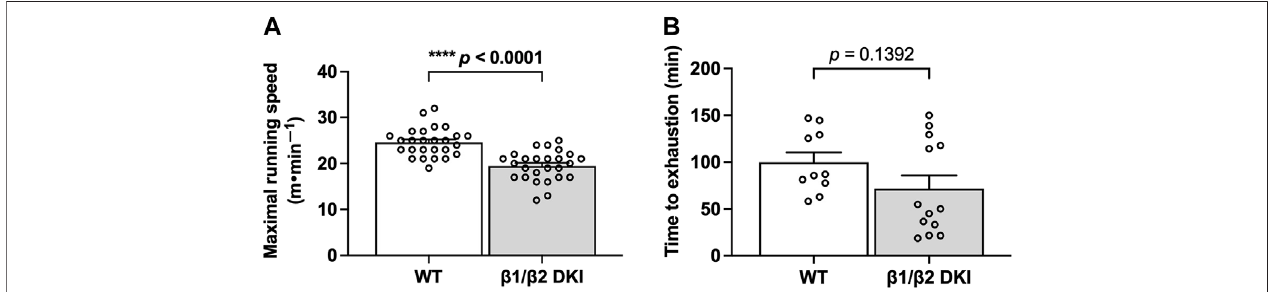
FIGURE 1 | The double knock-in (DKI) mutation used to disrupt whole-body AMPK-glycogen binding in mice reduces maximal running speed but does not alter timetoexhaustionatsubmaximalrunningspeed. (A) Maximalrunningspeedata0 ° treadmillinclineinwildtype(WT)andDKImice( n =26); (B) Timetoexhaustionat70% of individual maximal running speed at a 0 ° incline ( n = 10 – 13). Male mice, 17 – 21 wk **** p < 0.0001.